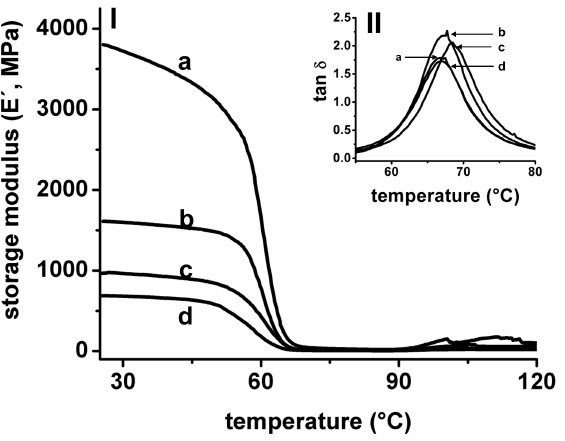
Figure 7. Storage modulus (E (cid:48) ) ( I ) and tan δ ( II ) measured in DMA from a temperature scan for single square (a), and single ellipsoidal (b) 3D-printed pieces. The E (cid:48) and tan δ of two 3D-printed pieces with ellipsoidal (c) and square (d) pores bonded forming a double composite are also